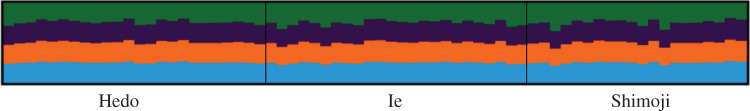
Result of STRUCTURE analysis. K = 4 with Mean (LnProb) = −1284.375 and Mean (similarity score) among 20 runs = 0.998 using 62 SNPs.